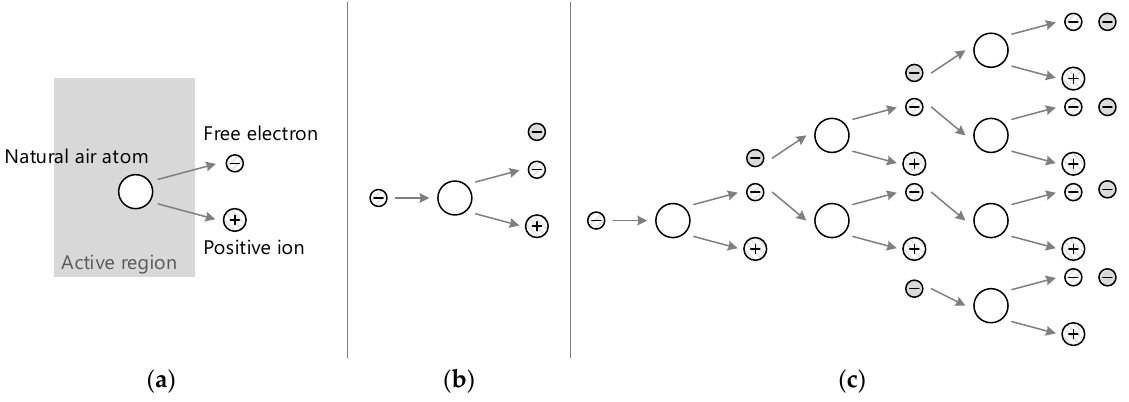
Figure 4. Electrical charge production. ( a ) Ionization of an air atom. ( b ) Colliding accelerated free electrons to another air atom and bumping another electron from the atom. ( c ) Ascending production of electrons and positive ions.